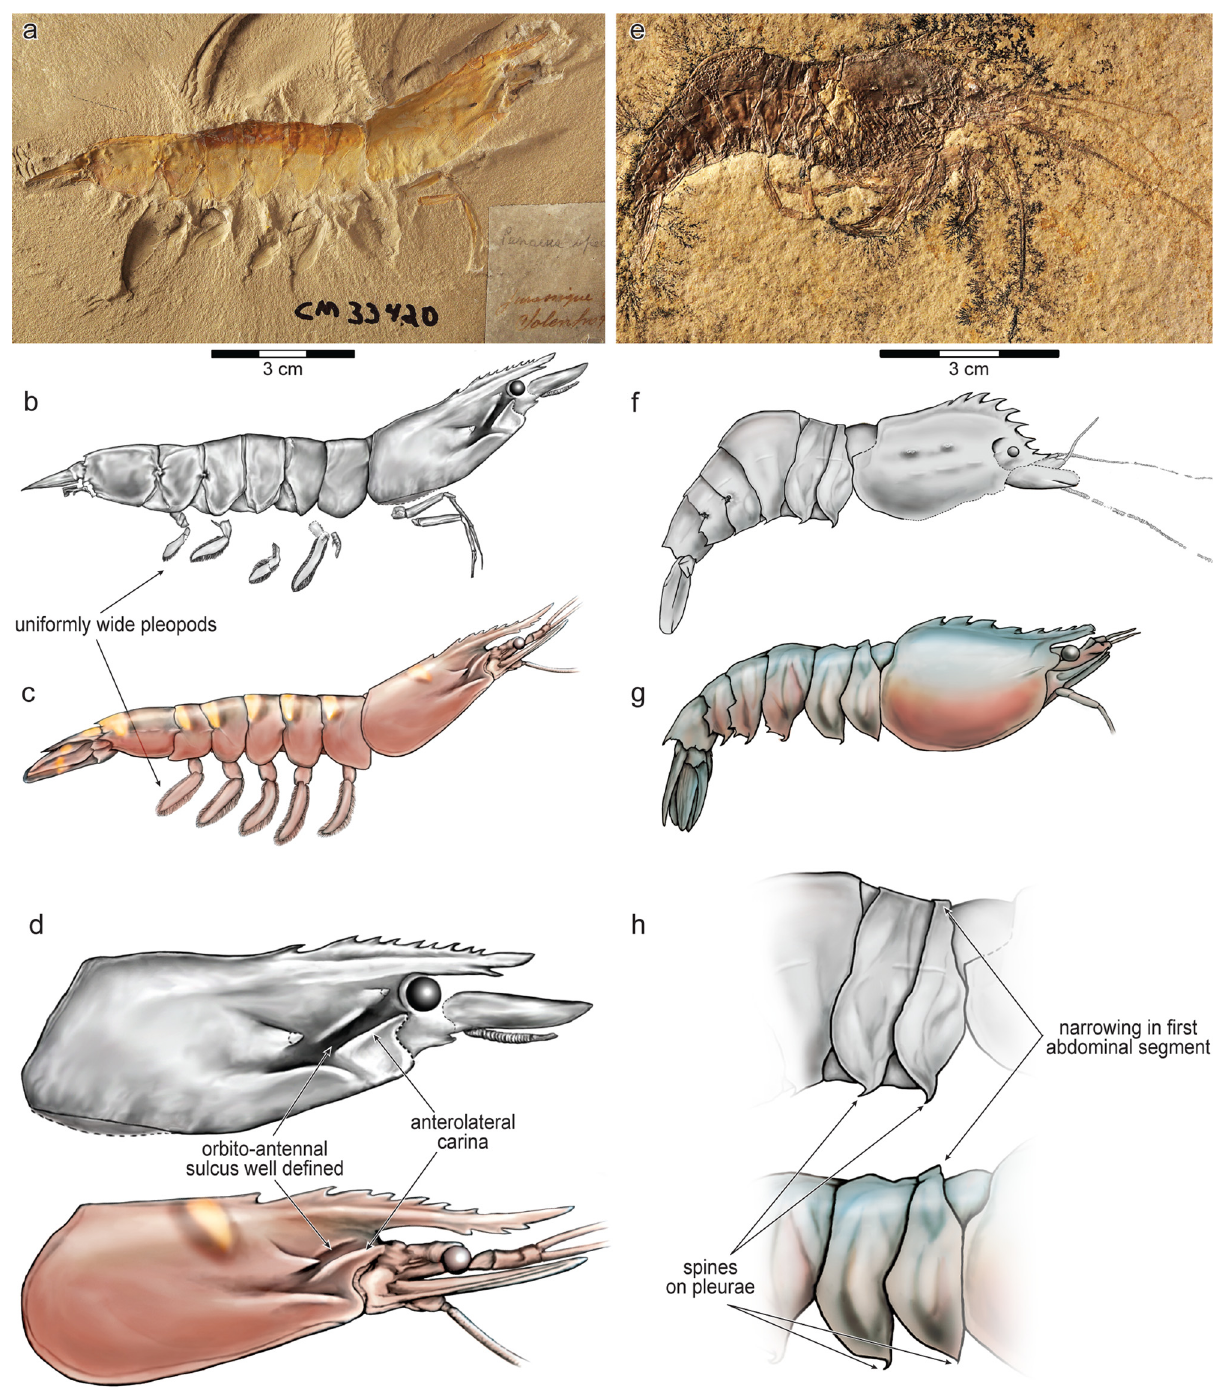
Fig 2. Members of Agripenaeina and Trachypenaeini from the Late Jurassic. † Antrimpos speciosus (panels a and b , CM-33420) and † Drobna deformis (panels e and f , CM-29467), fossils from the Solnhofen limestone, Germany (ca. 145 mya [18]) preserve key features that link them phylogenetically to shallow-water penaeoideans. † Antrimpos speciosus belongs to Agripenaeina, the clade accounting for 90% of shrimp farmed for human consumption, and is shown in comparison to Penaeus monodon ( c , giant tiger shrimp), a living member of Agripenaeina. † Drobna deformis is the sister taxon of Sicyonia (Trachypenaini), and is shown in comparison to the living Sicyonia lancifer ( g , rock shrimp). d and h show derived features shared by fossil and living shrimp. Additional synapomorphies for all clades are listed in S2 and S3 Tables. Scale bars = 3 cm.